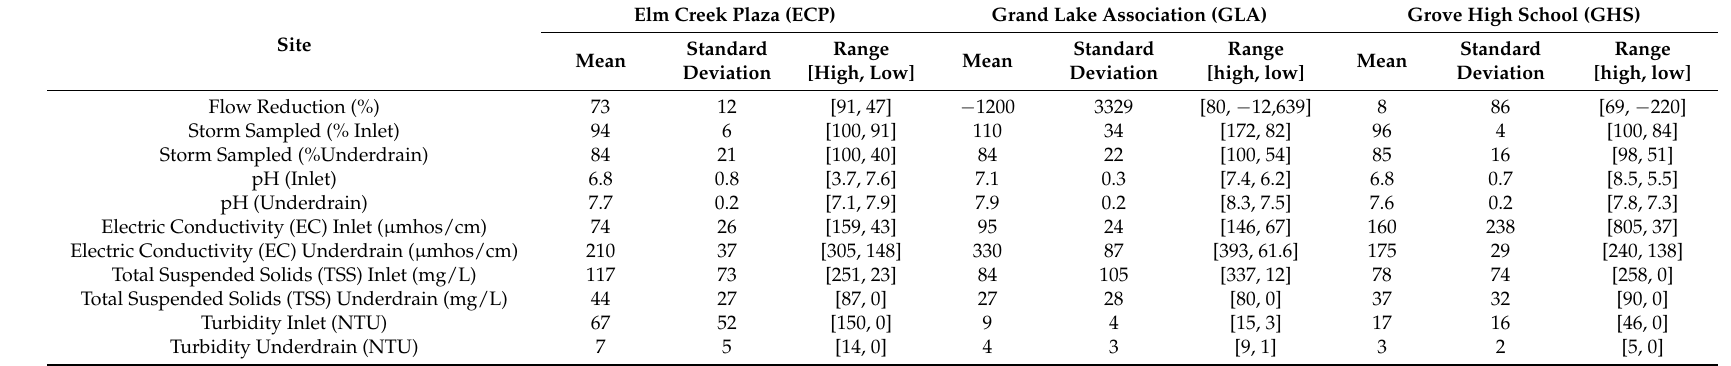
Table 4. Physical and chemical parameters for storm events from May 2014 to October 2015 for three bioretention cells in Grove,